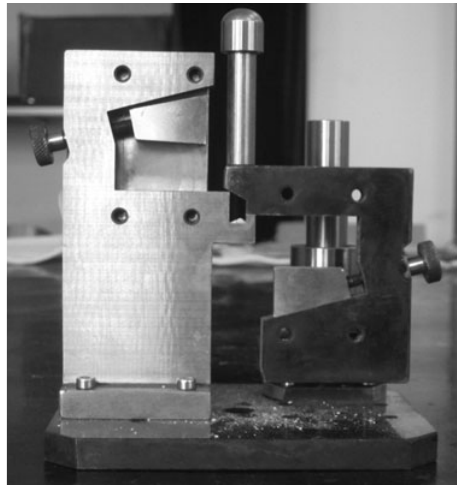
Figure 3 Test fi xture of iosipescu shear testing method.